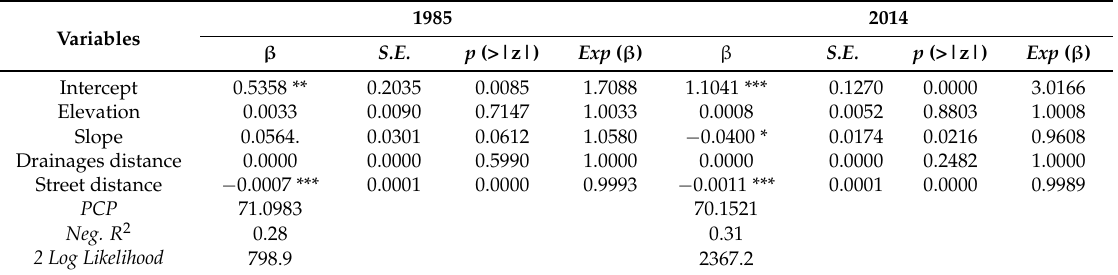
Table 6. Estimated results of the logistic regression model in Eastern Area of the four independent